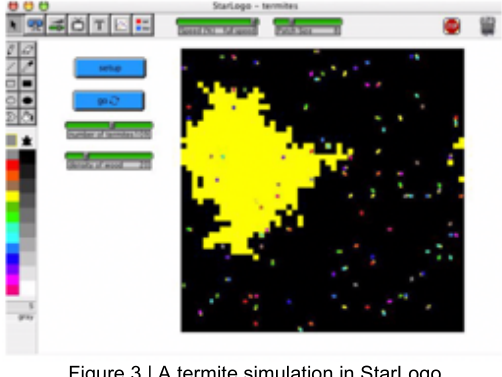
Figure 3 | A termite simulation in